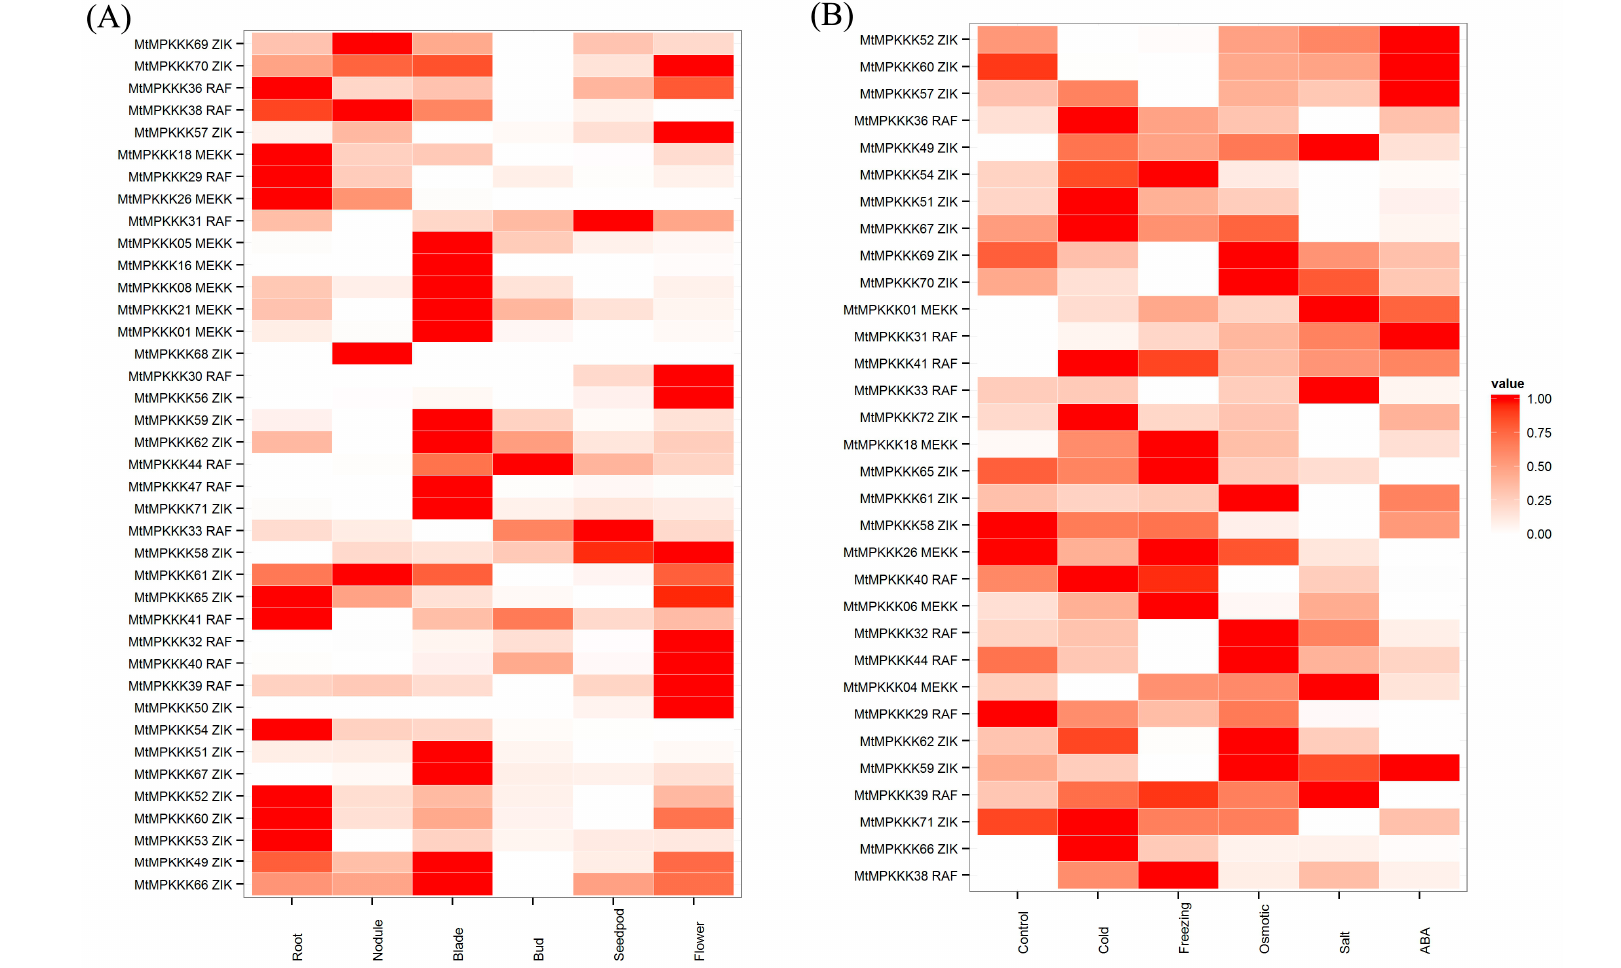
Figure 5. Expression profile cluster analysis of MtMAPKKK genes involving in tissue development ( A ) and response to abiotic stress ( B ).